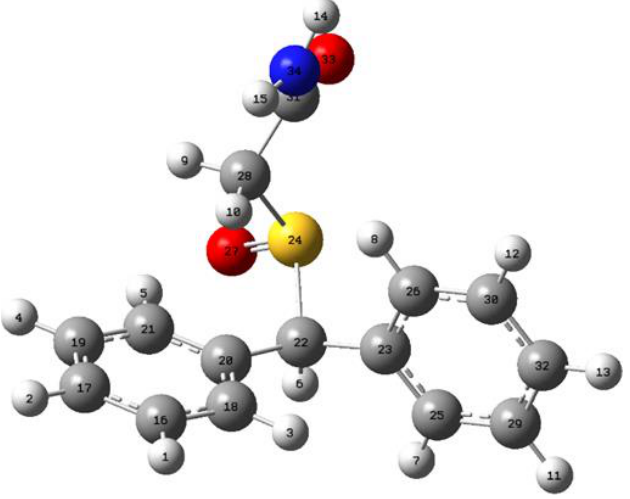
Figure 7. The structure and deprotonation positions of the armodafinil.